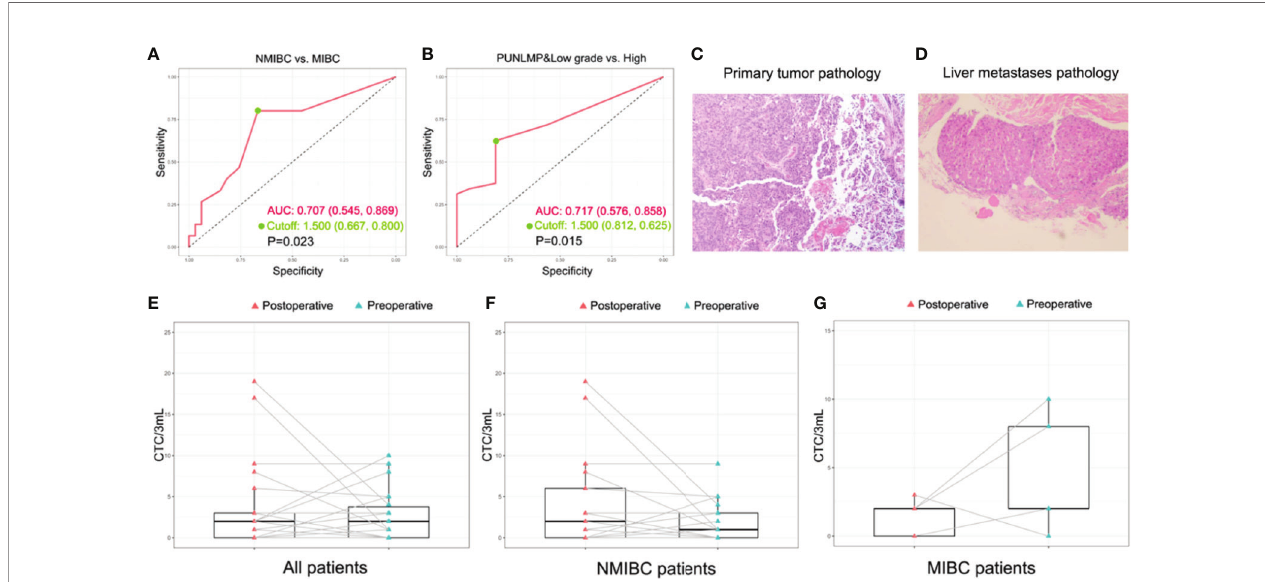
FIGURE 5 | Potential of CTCs as a prognostic biomarker for bladder cancer. (A, B) ROC analyses of CTCs as a prognostic biomarker for indicating tumor grade and invasiveness. (C, D) The histopathologic result of the primary bladder tumor and the liver metastasis of the patient with remote metastasis. The dynamic change of CTC count after surgery with regard to the whole patient cohort (E) , NMIBC group (F) , and MIBC group (G)